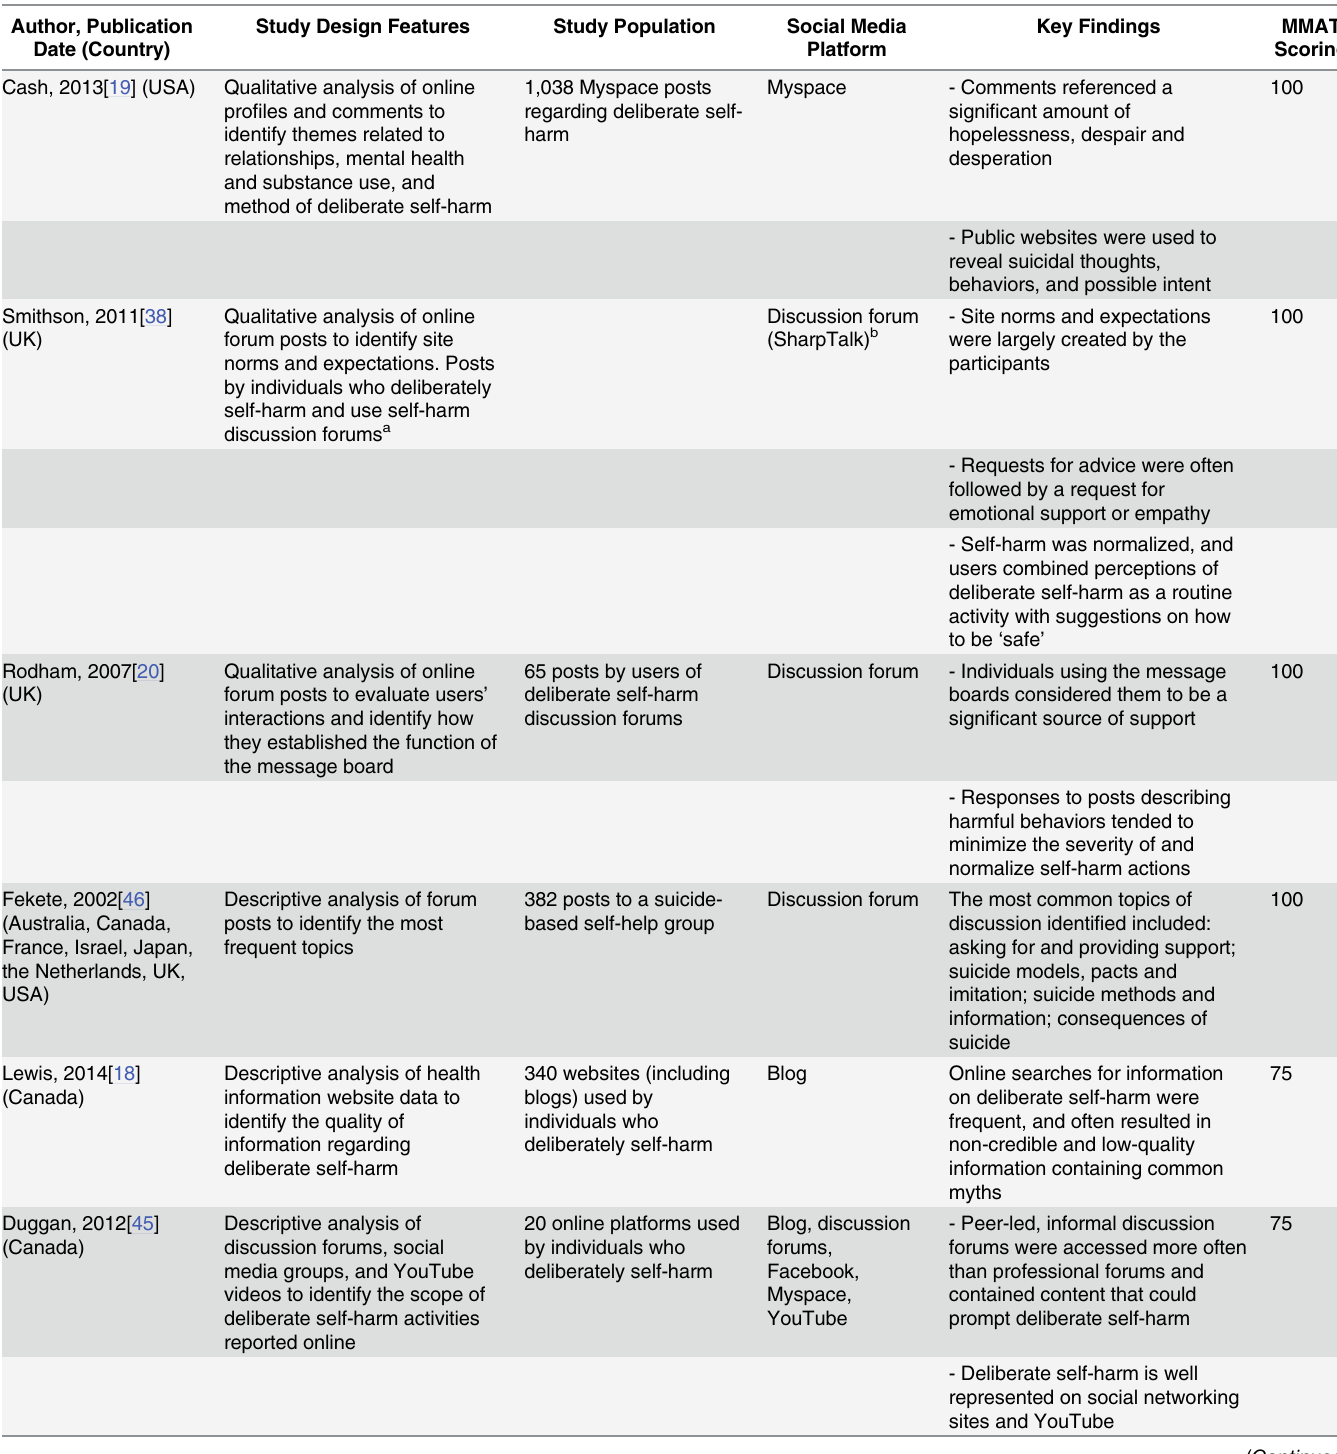
Table 2. Characteristics of studies reporting features of social media platforms used to discuss and view deliberate self-harm